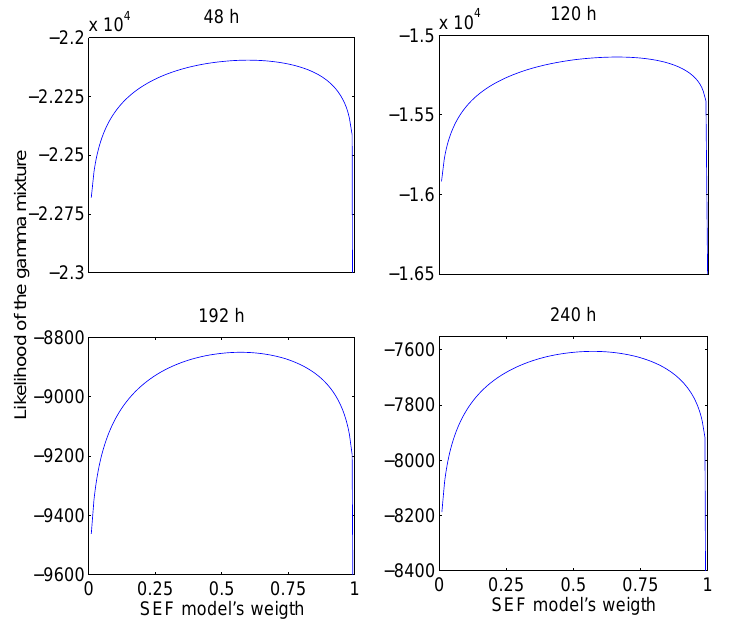
Fig. 6. Likelihood functions of the gamma mixture for the ensemble forecasts issued by models SEF and GEM, as a function of model SEF’s weight, for Maniwaki sub-catchment and 48h, 120h, 192h and 240h lead